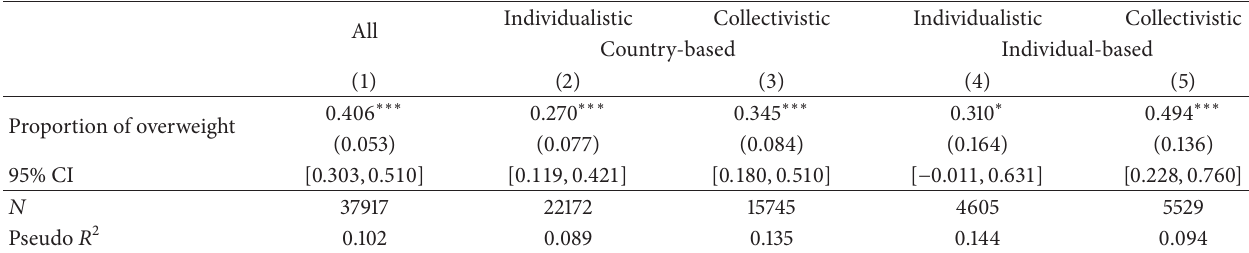
Table 4: Probit estimates of percentage of overweight on individual overweight (individualistic versus collectivistic, marginal effects).